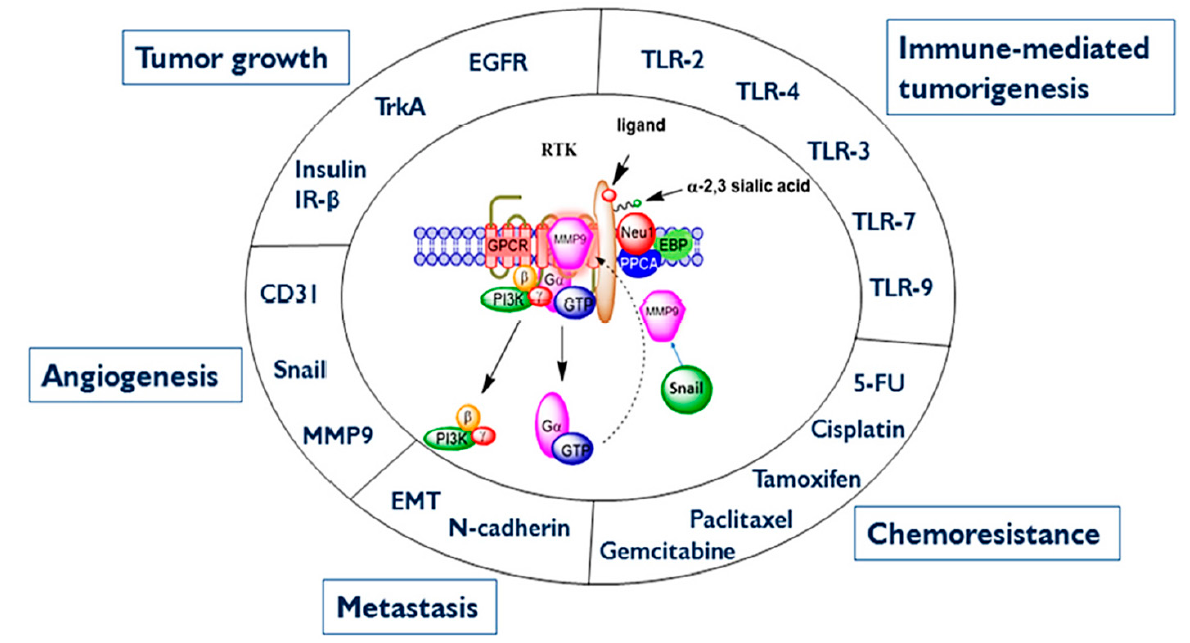
Figure 2. SNAIL and MMP-9 signaling axis in facilitating a neuraminidase-1 (Neu1) and matrix metalloproteinase-9 (MMP-9) crosstalk in regulating receptor tyrosine kinases (RTKs) in cancer cells to promote tumor neovascularization. Notes: Snail and MMP-9 expressions are closely connected in similar invasive tumor processes for cancer. Snail induces MMP-9 secretion via multiple signaling pathways, but particularly in cooperation with oncogenic H-Ras (RasV12), Snail leads to the transcriptional up-regulation of MMP-9. This Snail–MMP-9 signaling axis is the connecting link in promoting growth factor receptor glycosylation modification involving the subsequent receptor signaling platform of a Neu1-MMP-9 crosstalk tethered at the ectodomain of RTKs. Activated MMP-9 removes the elastin-binding protein (EBP) as part of the molecular multi-enzymatic complex that contains β -galactosidase/Neu1 and protective protein cathepsin A (PPCA). Activated Neu1 hydrolyzes α -2,3-sialic acid residues of RTKs at the ectodomain to remove steric hindrance to receptor association and activation. This process sets the stage for SNAIL’s role in tumor neovascularization. Abbreviations : GPCR, G protein-coupled receptor; Pi3K, phosphatidylinositol 3-kinase; GTP, guanine triphosphate; EBP, elastin-binding protein; PPCA, protective protein cathepsin A. Citation: [19] Taken in part from Research and Reports in Biochemistry 2013:3 17–30. © 2013 Abdulkhalek et al.,